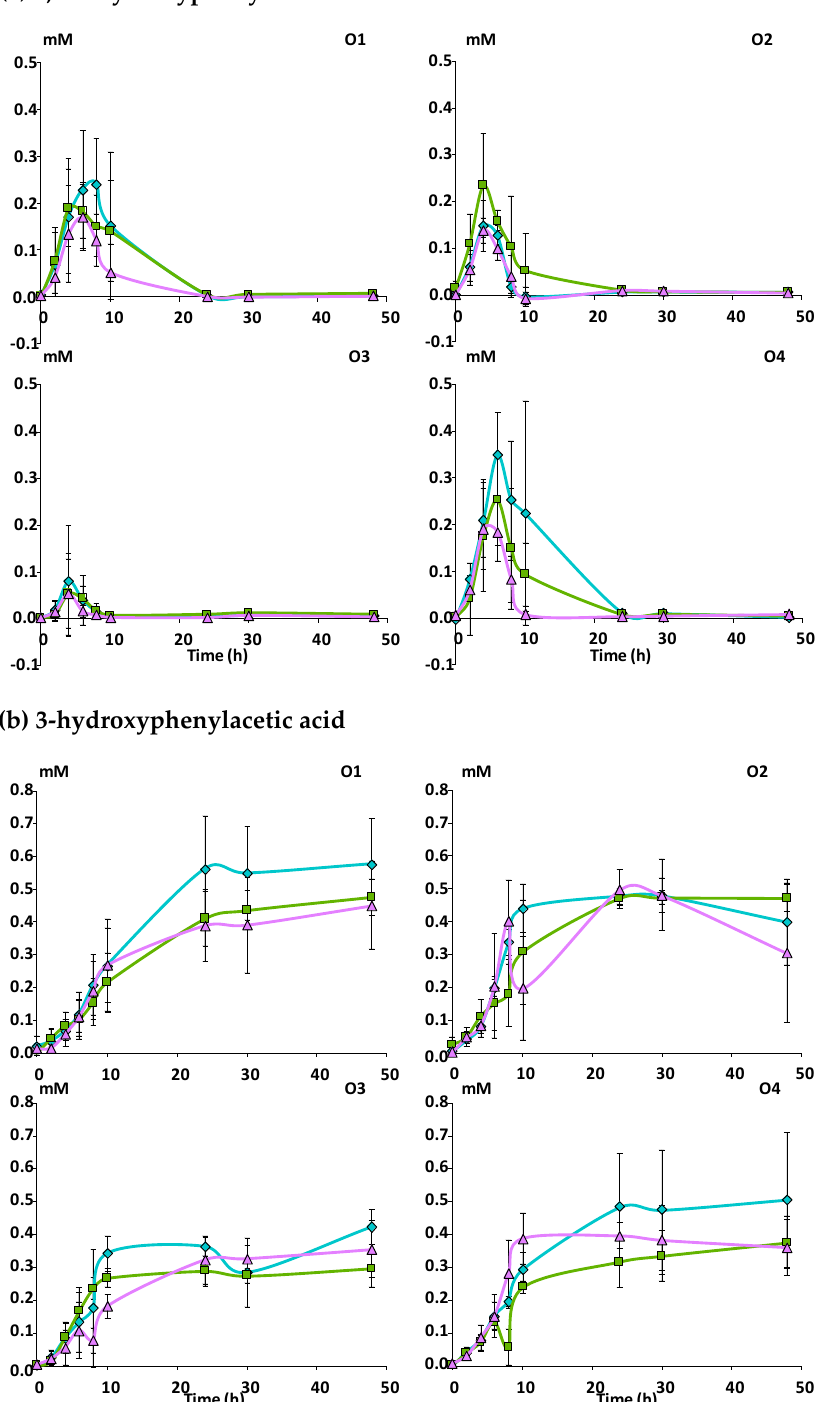
Figure 3. Kinetics of production of phenylpropionic acid derivatives during in vitro fermentation of the apple matrices with fecal microbiota ( n = 3) from four healthy subjects. Mean Figure 1. Kinetics of production of short chain fatty acids during in vitro fermentation of the Figure 4. Kinetics of production of phenylacetic acid derivatives during in vitro fermentation of concentrations in mM of ( a ) 3-(3,4-dihydroxyphenyl)propionic acid, ( b ) 3-(3- apple matrices with fecal microbiota ( n = 3) from four healthy subjects. Experimental and Figure 4. Kinetics of production of phenylacetic acid derivatives during in vitro fermentation of Figure 4. Kinetics of production of phenylacetic acid derivatives during in vitro fermentation of the apple matrices with fecal microbiota ( n = 3) from four healthy subjects. Mean concentrations hydroxyphenyl)propionic acid, (c) 3-(4-hydroxyphenyl)propionic acid, (d) 3-phenylpropionic modelled data for acetate ( a ) propionate ( b ) and butyrate production ( c ). Each point represents the apple matrices with fecal microbiota ( n = 3) from four healthy subjects. Mean concentrations in the apple matrices with fecal microbiota ( n = 3) from four healthy subjects. Mean concentrations in mM of ( a ) 3,4-dihydroxyphenylacetic acid and ( b ) 3-hydroxyphenylacetic acid. Error bars acid. Error bars represent the standard error of the mean ( n = 3 ). O1 to O4: subject 1 to 4. Mcov the mean concentrations of SCFAs expressed in mM. Bars represent the standard error of the mM of ( a ) 3,4-dihydroxyphenylacetic acid and ( b ) 3-hydroxyphenylacetic acid. Error bars represent in mM of ( a ) 3,4-dihydroxyphenylacetic acid and ( b ) 3-hydroxyphenylacetic acid. Error bars represent the standard error of the mean ( n = 3 ). O1 to O4: subject 1 to 4. Mcov matrix, matrix, Mnc matrix, Mno matrix. the standard error of the mean ( n = 3). O1 to O4: subject 1 to 4. mean ( n= 3 ). O1 to O4: subject 1 to 4. Mcov matrix, Mnc matrix, Mno matrix represent the standard error of the mean ( n = 3 ). O1 to O4: subject 1 to 4. Mcov matrix, Mnc matrix, Mno matrix. Mno (a) 3,4-dihydroxyphenylacetic acid Mnc matrix, Mno matrix. Table 2. Rates of SCFA production and procyanidin degradation during in vitro fermentation of the apple matrices with fecal microbiota ( n = 3) from four healthy donors 1.